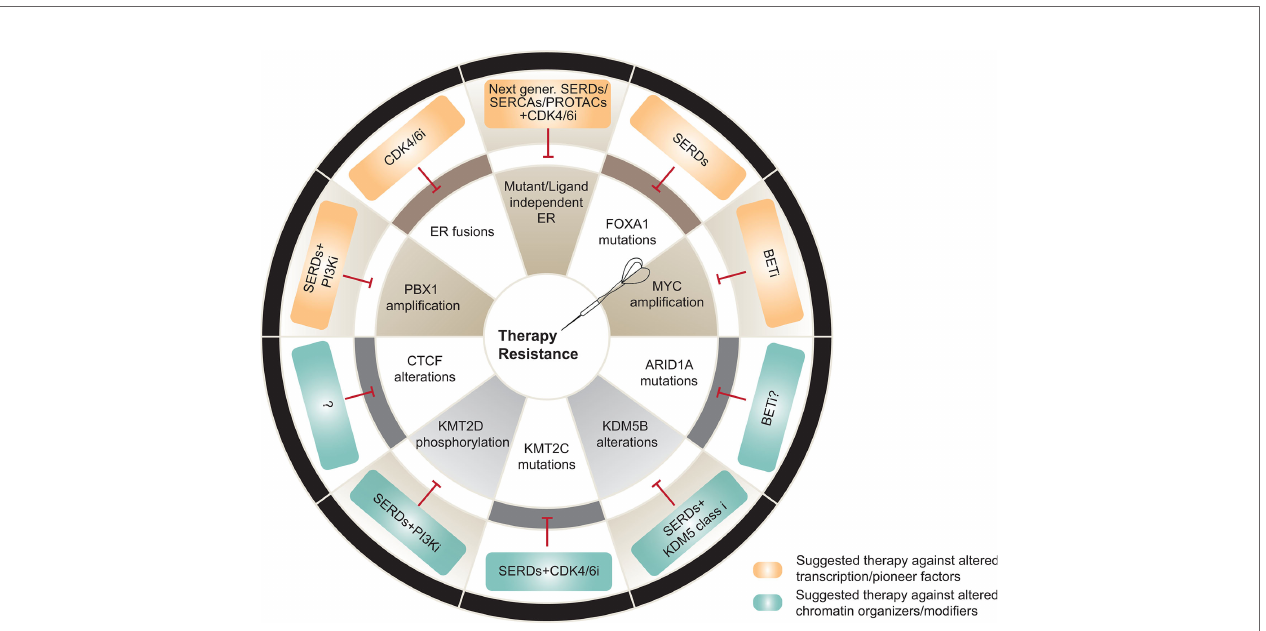
FIGURE 2 | Transcriptional and epigenetic mechanisms of therapy resistance and potential therapeutic alternatives to overcome them. Top, Alterations in transcription and pioneer factors involved in resistance (brown) and suggested therapeutic strategies against the driven mechanisms (orange). Bottom, Alterations in chromatin organizers and modi fi ers associated to resistance (grey) and suggested therapeutic strategies against the driven mechanisms (blue). SERD, selective estrogen receptor degraders; SERCA, selective ER covalent antagonists; PROTAC, proteolysis-targeting chimeras. Figure adapted and modi fi ed from